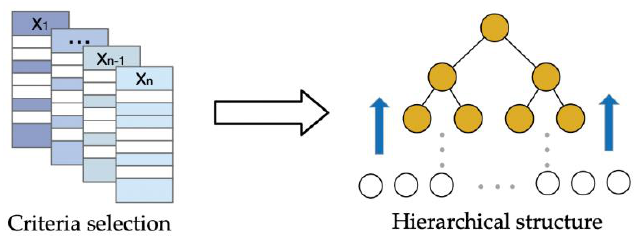
Figure 4. The hierarchical classification structure.